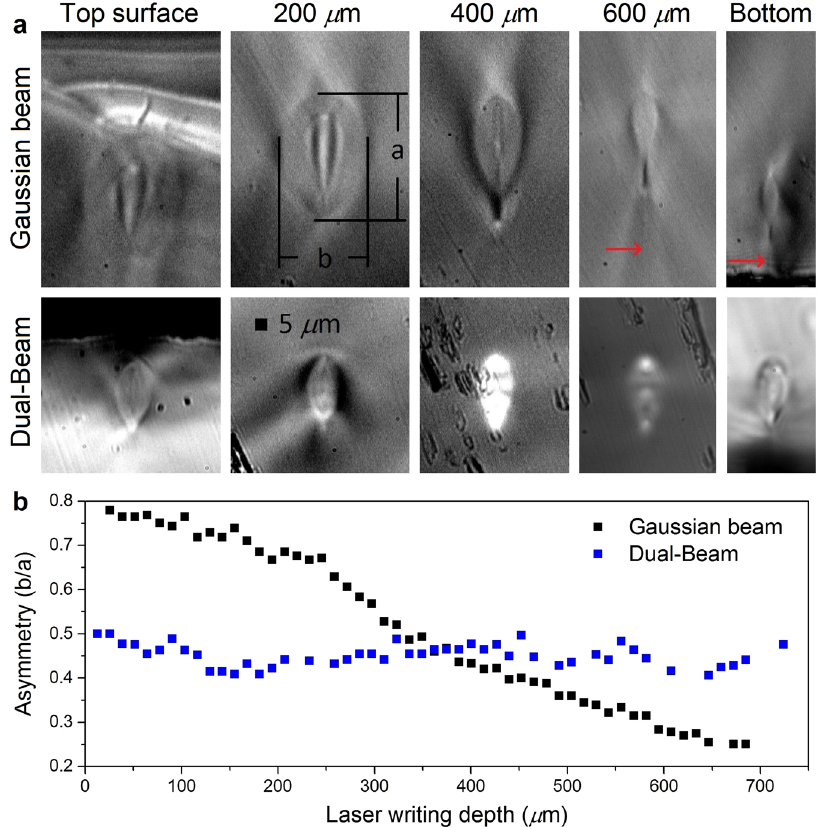
Figure 6. The laser writing depth dependency is strongly reduced using the Dual-Beam technique compared to the conventional focusing technique. ( a ) Facet view of the waveguides at different depths. Note that the red arrows show weak filaments produced under low energy pulses (1 μ J) as discussed earlier. ( b ) Graph of the measured asymmetry showing the depth of writing